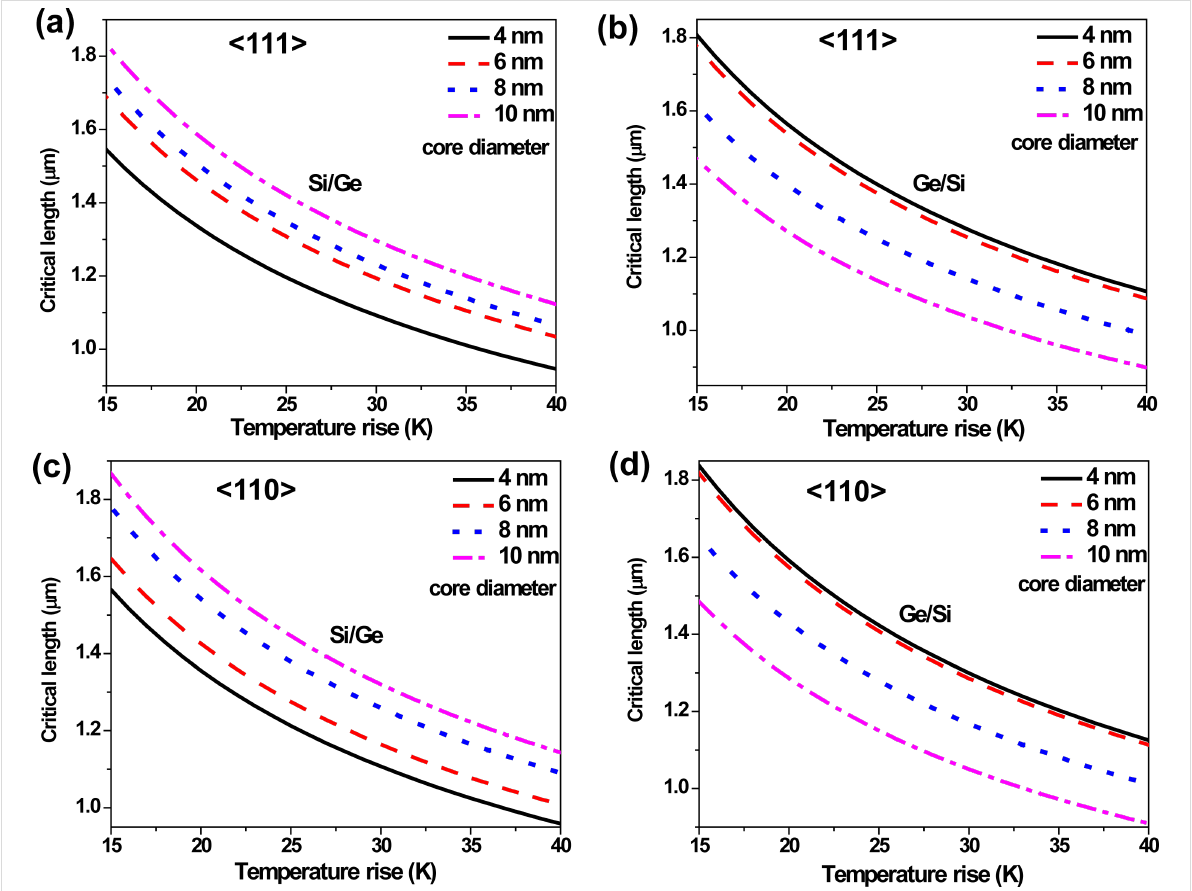
Figure 6: Stability diagrams for CSNWs of (a) Si/Ge <111>, (b) Ge/Si <111>, (c) Si/Ge <110> and (d) Ge/Si <110> configurations. Any combination of temperature increase and nanowire length is safe so long as it remains below the corresponding stability